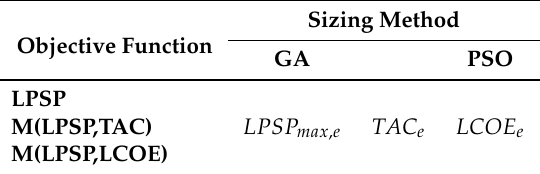
Table 6. Structure of experimental design for analysis of interaction factors, where e = 1, 2,...,